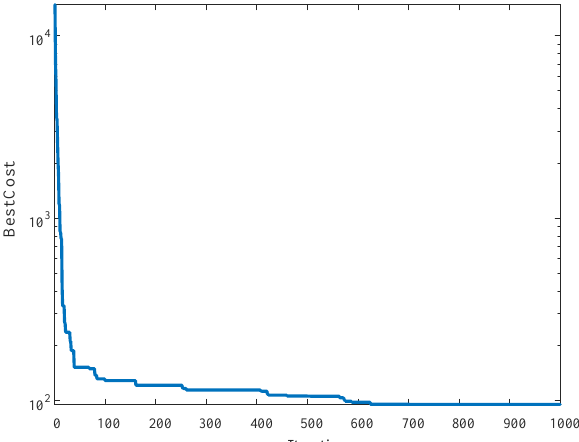
Figure 10. Optimization curve based on quantum genetic algorithm. Table 2. Optimized setting parameters of inverse-time over-current protection.